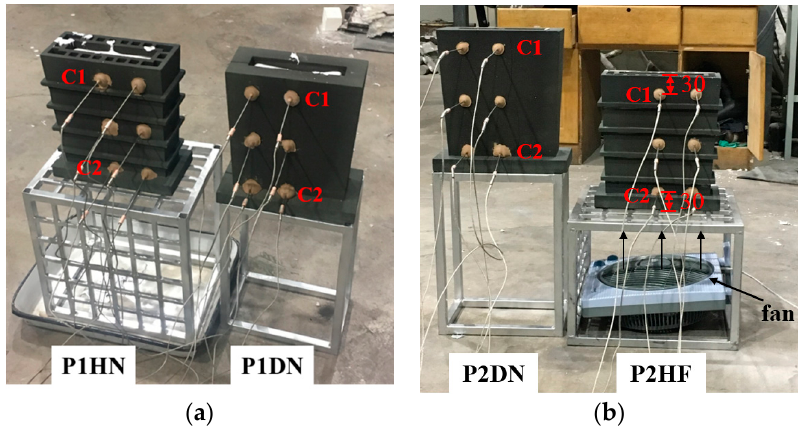
Figure 7. On-site pouring experiments: ( a ) natural cooling and ( b ) forced cooling. (C1 is the test point at the top of the molds, 30 mm from the top of the molds, C2 is the test point at the bottom of the molds, 30 mm from the bottom of the molds.)